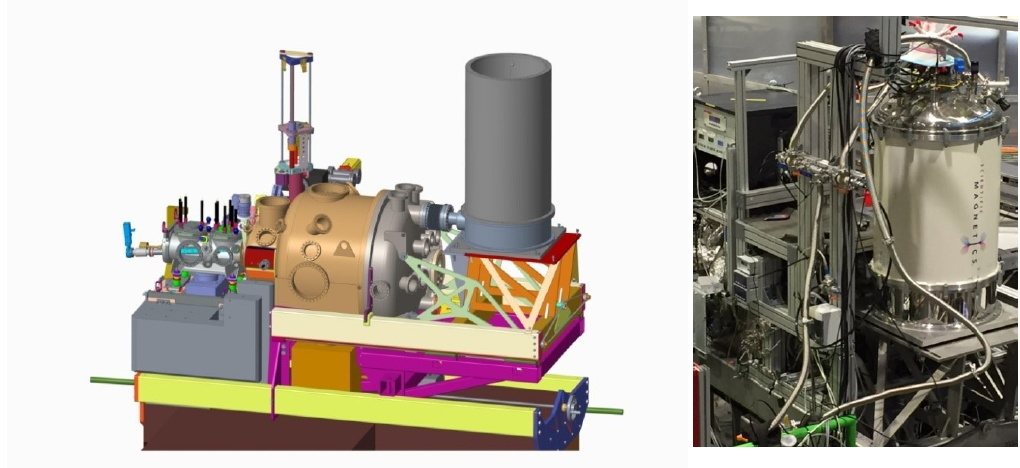
Figure 1: Coherent soft x-ray scattering end station at the